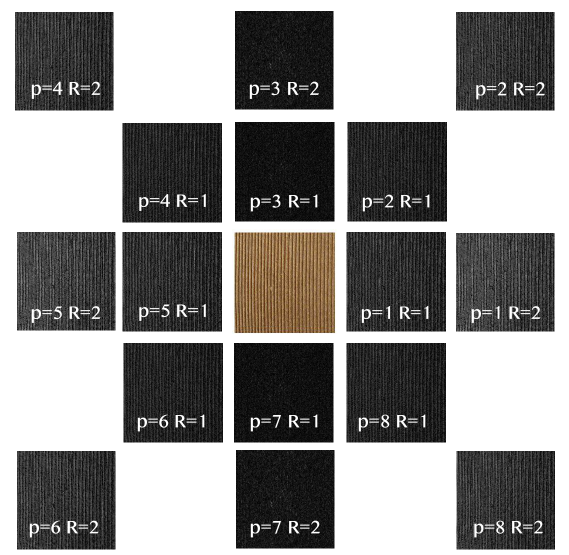
Figure 2. ∆ p images showing the absolute differences of the gray values for P = 8 orientations in a neighborhood of radii R = 1 and R = 2. The original image I is shown in the center. The main change in the intensity of the original image occurs in the horizontal direction p = 1 and p =